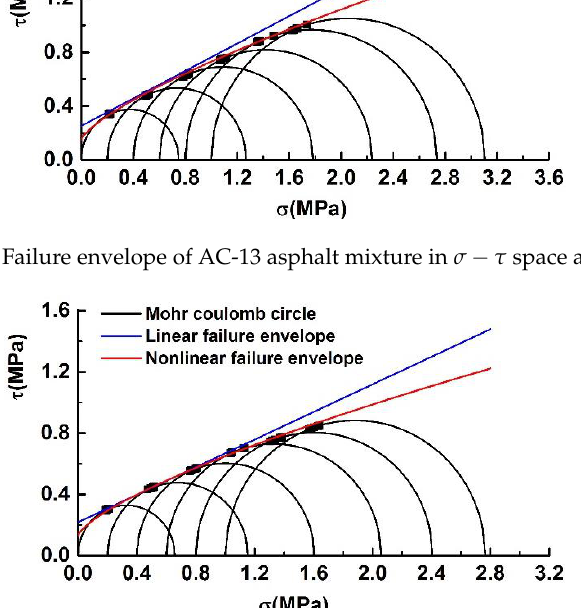
 −  −  − space at 60 °C. space at 60 °C. Figure 10. Failure envelope of OGFC-13 asphalt mixture in σ − τ space at 60 ◦ space at 60 °C.